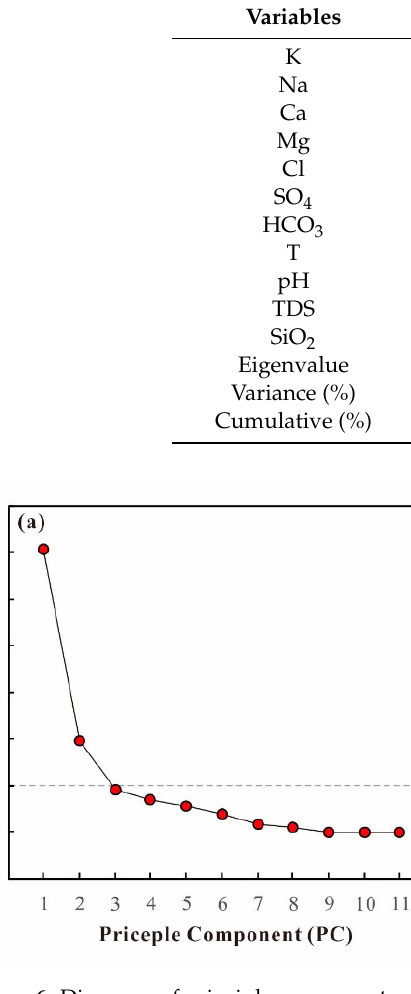
Figure 6. Diagrams of principle component analysis, ( a ) scree plot, ( b ) factor loadings for PC1 and PC2. Table 1. Factor loadings and eigenvalues of the eleven extracted factors.